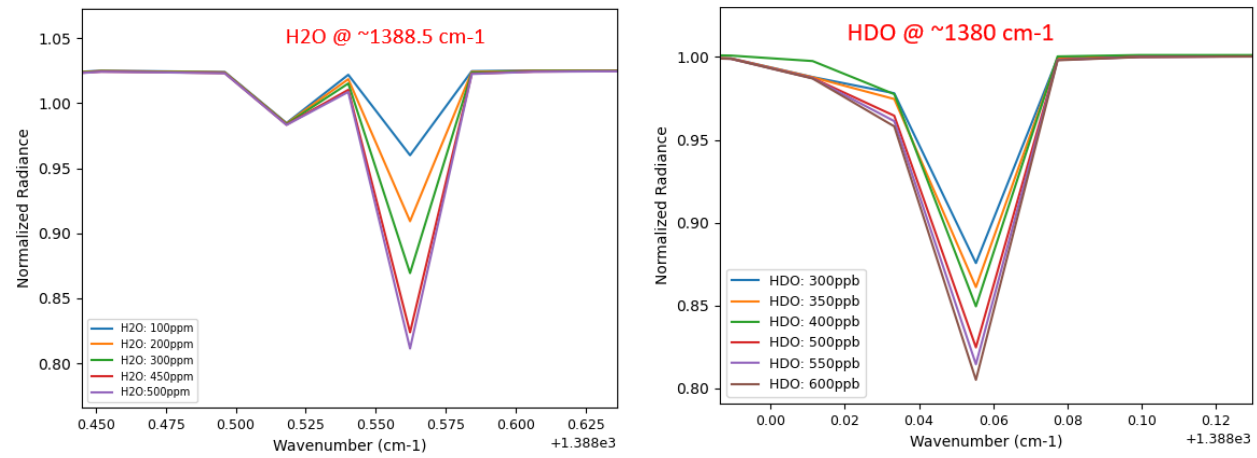
Figure 16. Variation of the abundances of HDO and H 2 O in EXES simulations. The depth of the lines linearly increases with their abundances. ( Left panel ) HDO = 450 ppb for H 2 O = 100 ppm, 200 ppm, 300 ppm, 450 ppm and 500 ppm; ( Right panel ) H 2 O = 318 ppm, for HDO = 300 ppb, 350 ppb, 400 ppb, 500 ppb, 550 ppb and 600